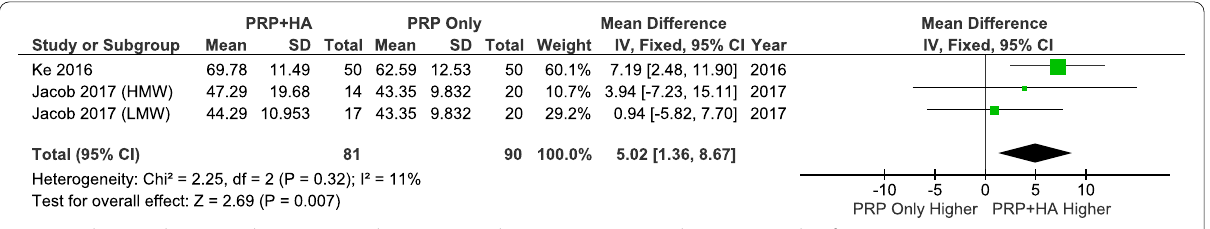
Fig. 16 Showing the Forest plot comparing the IKDC scores between PRP